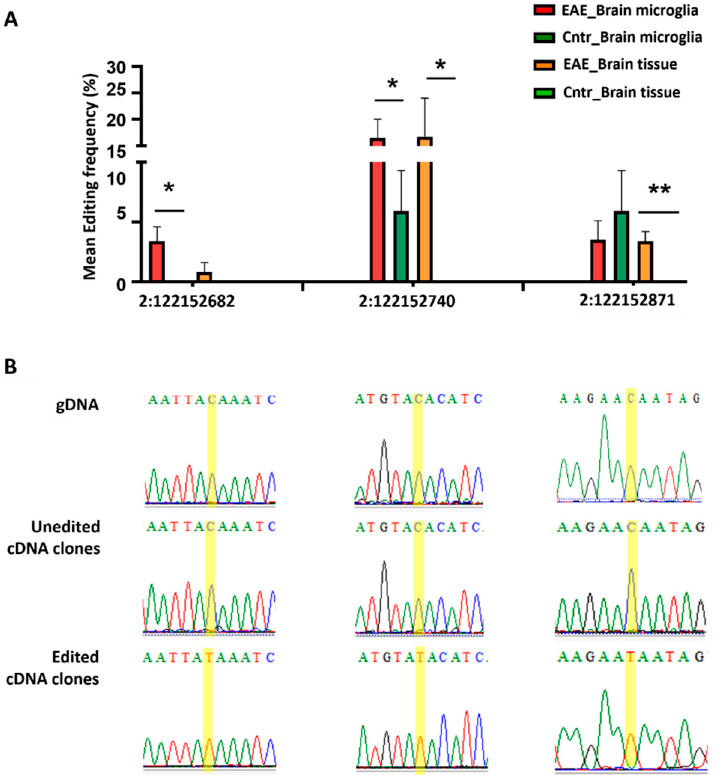
Figure 3. Naïve and acute EAE murine microglia displayed different profiles and frequencies of APOBEC-mediated (C-U-T) RNA editing within the 3 ′ UTR of the B2m transcript (increased editing frequency in disease condition); a similar B2m -3 ′ UTR editing pattern was detected in brain tissue. ( A ) . Graphical representation of the experimentally validated and statistically significant C-U-T editing events between naïve and acute EAE microglia and brain tissue, based on the direct comparison of cDNA clones with corresponding gDNA sequences through Sanger sequencing. Four tech- nical replicates of brain microglia samples were used per condition (EAE, Cntr), including at least 20 (EAE) or 10 (Cntr) clones per replicate. Brain tissue analysis was performed on three biological replicates per condition ( n = 3 EAE, n = 3 Cntr), including the analysis of at least 30 clones per sample. For editing frequency quantification, the percentage (%) of cDNA clones displaying the edited base relative to the total number of tested clones per sample was utilized. The bars indicate the mean editing frequency per sample type and condition. Error bars correspond to standard error. For Sta- tistical analysis, one-tailed unpaired t-test was performed. Significance symbols are as follows: * p ≤ 0.05, ** p ≤ 0.01. ( B ) . Representative chromatograms from Sanger sequencing analysis of gDNA and un-edited and edited cDNA clones harboring the positions of interest (highlighted in yellow). De- tailed Sanger sequencing analysis data (alignments) is provided in Figures S7 (microglia) and S8 (brain tissue). A similar editing pattern was observed when B2m 3 ′ UTR analysis was performed in brain tissue from naïve and acute EAE mice, allowing for the identification of three edited